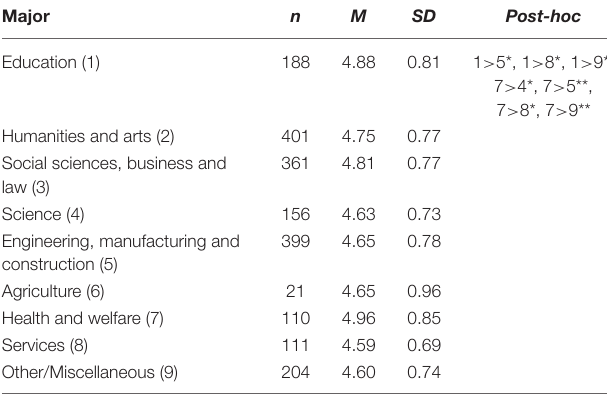
TABLE 8 | Post-hoc (Bonferroni) analyses among gender and grade levels. Gender Grade level M female ( SD )